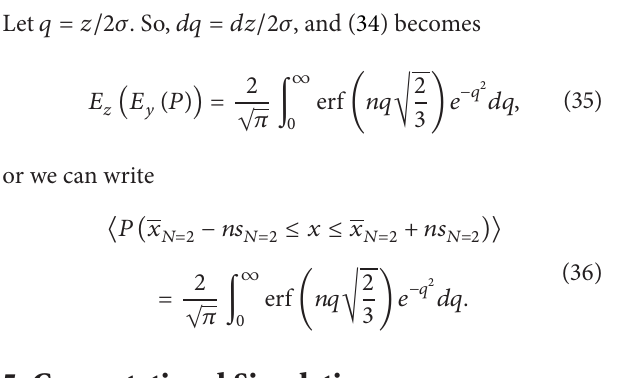
∞ erf (𝑛𝑞√2/3)𝑒 −𝑞 0